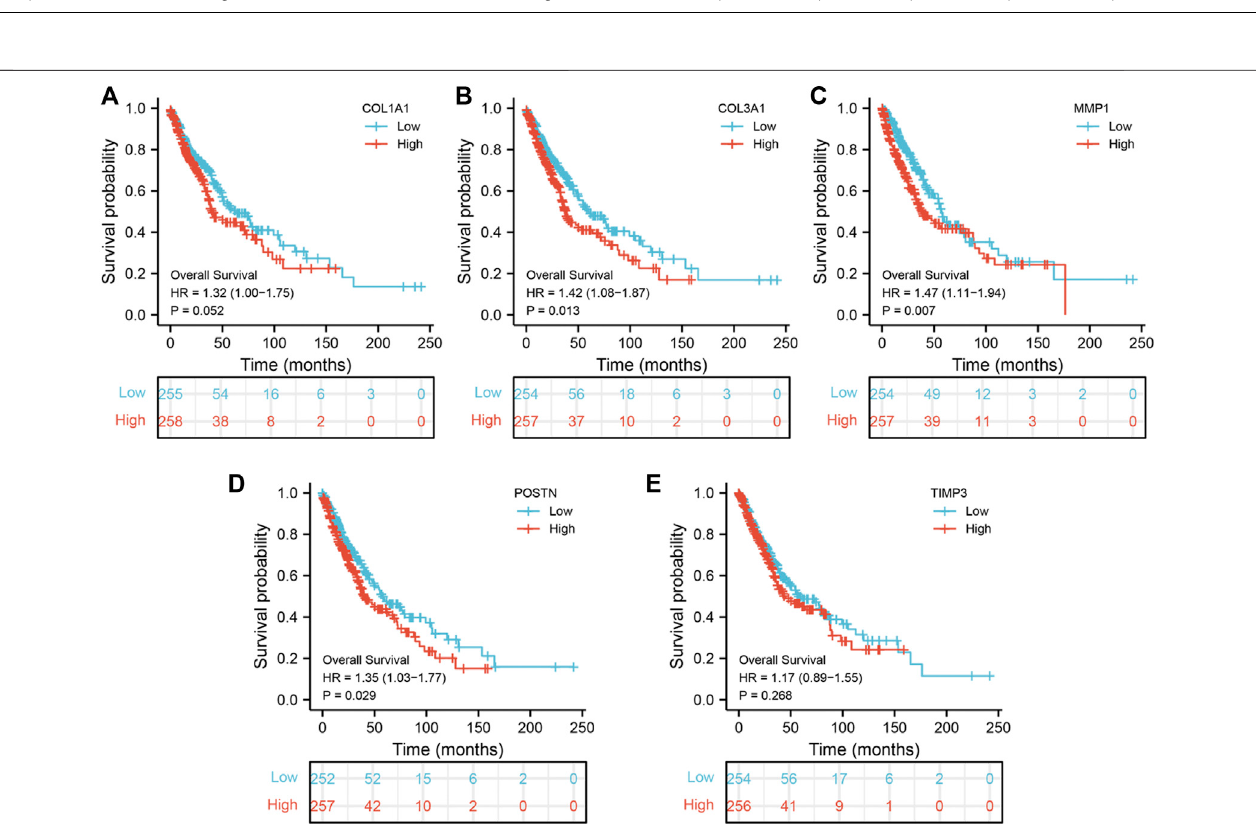
FIGURE 4 | Prognosis value of hub genes. Notes: (A) : Kaplan-Meier curves showed the prognosis value of COL1A1 in NSCLC patients; (B) : Kaplan-Meier curves showed the prognosis value of COL3A1 in NSCLC patients; (C) : Kaplan-Meier curves showed the prognosis value of MMP1 in NSCLC patients; (D) : Kaplan-Meier curves showed the prognosis value of POSTN in NSCLC patients; (E) : Kaplan-Meier curves showed the prognosis value of TIMP3 in NSCLC patients.